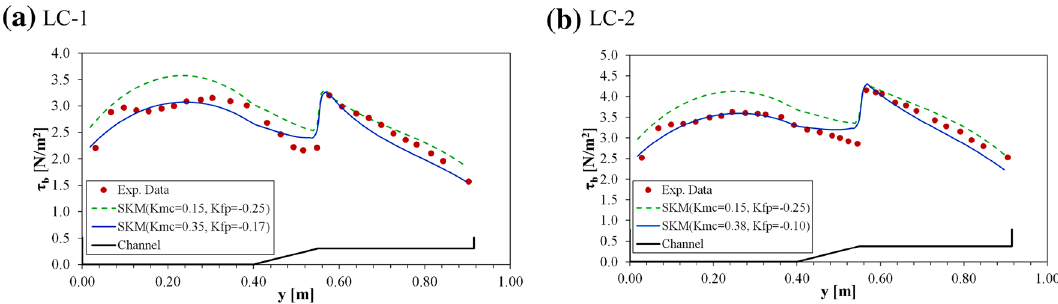
Fig. 5 Results of boundary shear stresses for large-scale compound channels (the solid line: k calibrated by Devi and Khatua approach, the dashed line: k assumed as Abril and Knight